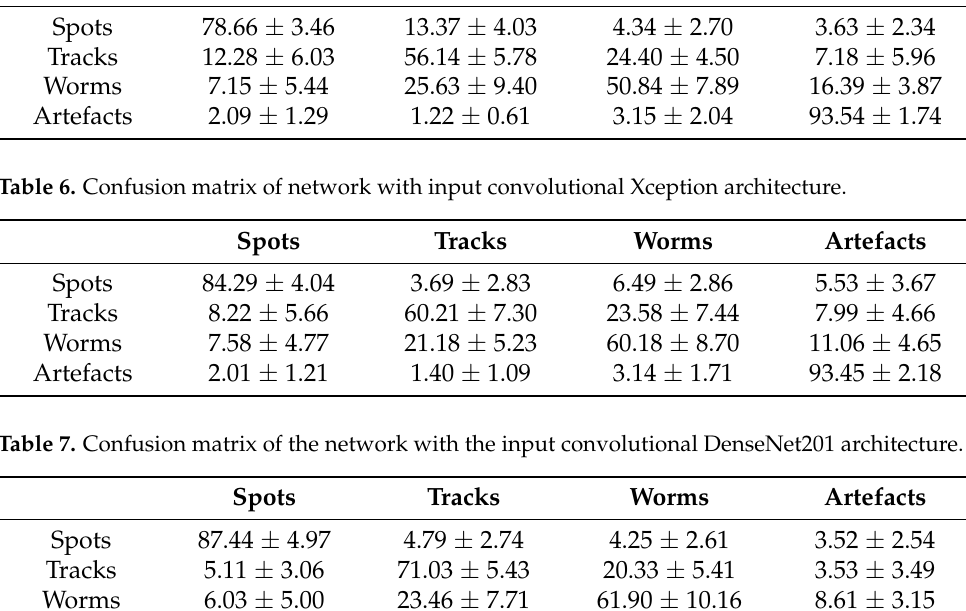
Table 5. Confusion matrix of the network with the input convolutional MobileNetV2 architecture. Spots